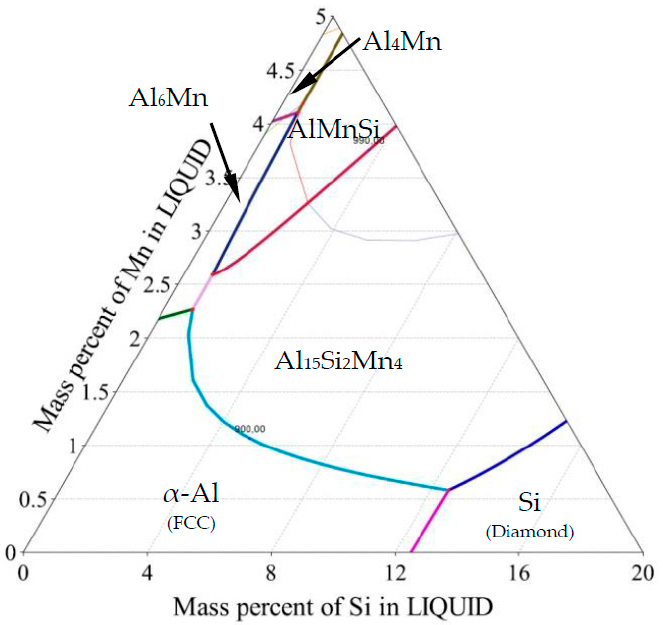
Figure 1. Ternary phase diagram—Al-Si-Mn system: Liquidus projection of Al rich corner.